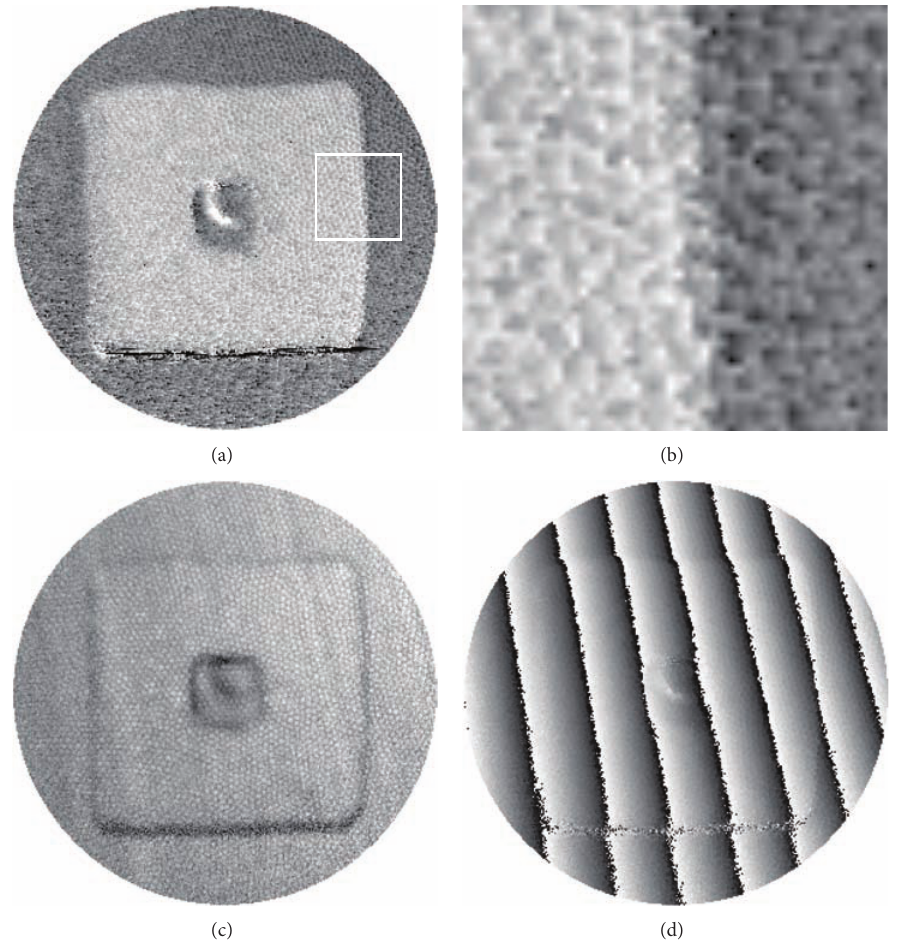
Figure 13: Underwater experiment. (a) Unfiltered height map. (b) Magnified white square region in (a). (c) Fringe contrast map. (d) Wrapped phase map.